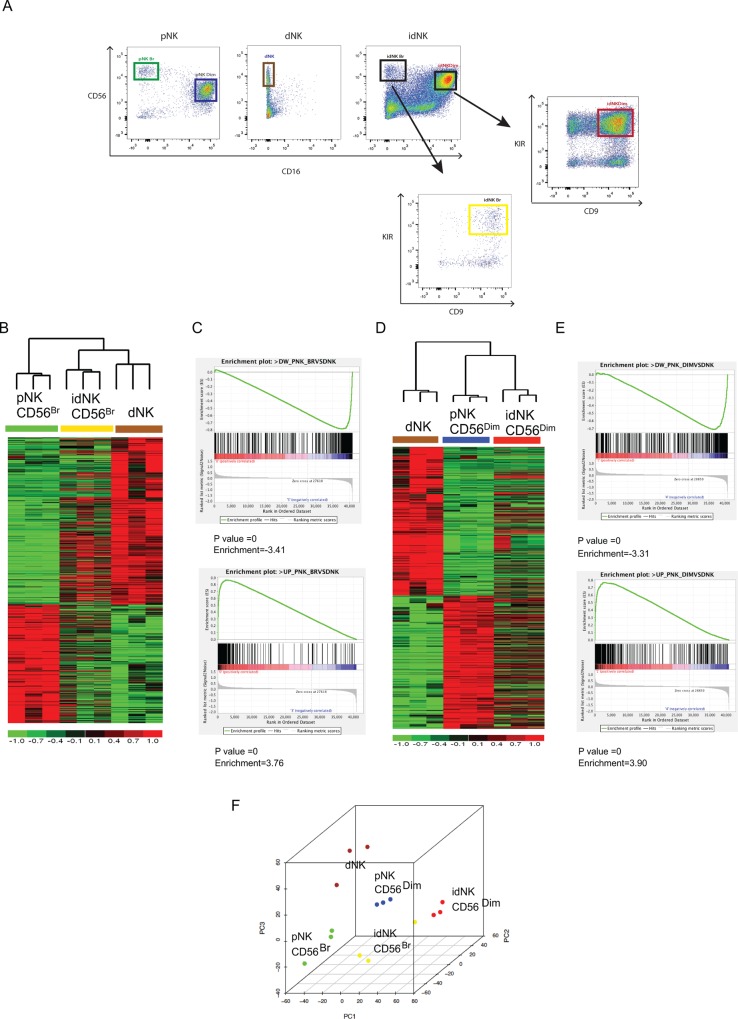
Characterization of idNK cells by transcriptome profiling.(A) Gating strategy used to FACS sort dNK, pNK CD56Bright, pNK CD56Dim, idNK CD56Bright and idNK CD56Dim (both idNK populations sorted as CD9+ KIR+ cells), used for microarray gene expression profiling. Plots are gated on CD3- cells. Heatmap of genes differentially expressed (Fold change > 2 and FDR < 0.05) in pNK CD56Bright vs. dNK (B) or in pNK CD56Dim vs. dNK (D). Heatmaps also include idNK CD56Bright (B) or idNK CD56Dim samples (D) to explore correlation in their expression pattern with pNK CD56Bright (B) or pNK CD56Dim (D) and dNK samples. Columns represent samples, and rows represent genes, with expression in pseudocolor scale (–1 = green, +1 = red). C and E) Gene set enrichment analysis comparison of expression using geneset based permutations. Genes significantly downregulated in pNK CD56Bright vs. dNK shown significant downregulation patterns in pNK CD56Bright compared to idNK CD56Bright (FDR P value = 0, Normalized enrichment score [NES] = 3.41) [C, Upper Panel]. Genes significantly upregulated in pNK CD56Bright vs. dNK shown significant upregulation patterns in pNK CD56Bright compared to idNK CD56Bright (FDR P value = 0, NES = 3.76) [C, Lower Panel]. Genes significantly downregulated in pNK CD56 Dim vs. dNK did not show significant downregulation patterns in pNK CD56Dim compared to idNK CD56Dim (P value = 0, NES = 3.38) [E, Upper Panel]. Genes significantly upregulated in pNK CD56Dim vs. dNK shown significant upregulation patterns in pNK CD56Dim compared to idNK CD56Dim (P value = 0, NES = 3.90) [E, Lower Panel]. (F) Unsupervised principal component analysis based on coding genes All analyses exclude Y chromosome encoded genes.